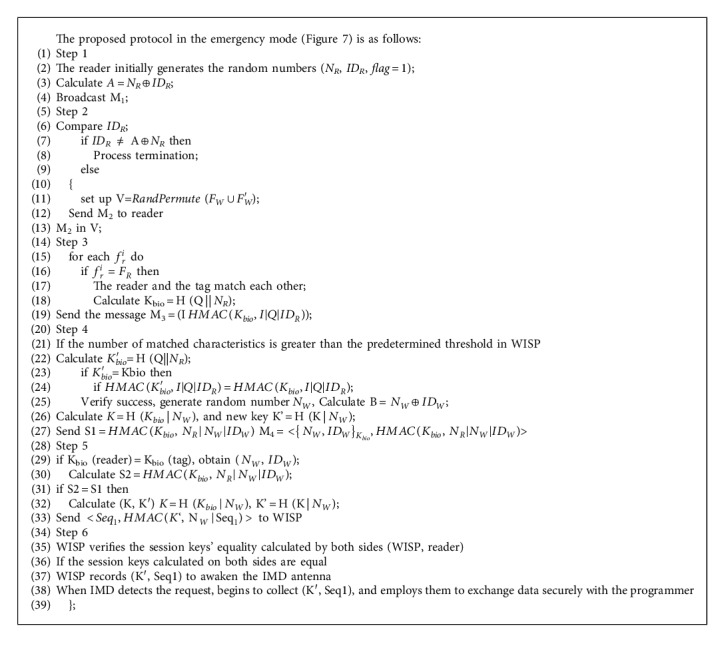
The suggested mutual authentication protocol in the emergency mode.